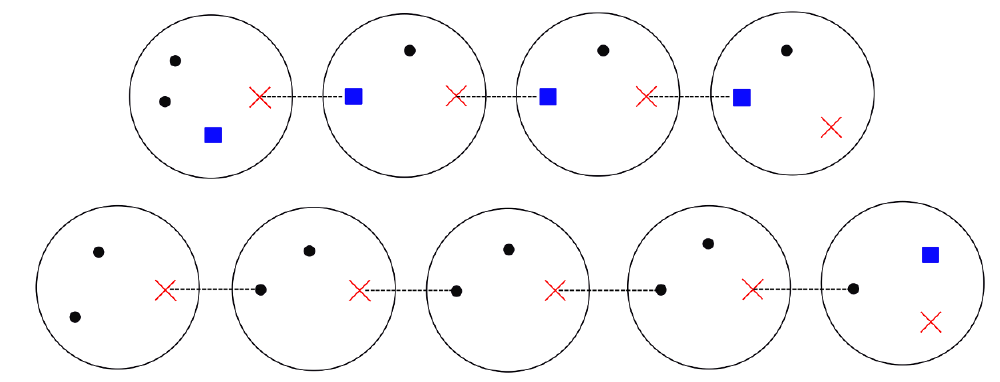
Figure 9 . The linear quiver that we will examine for k small, when g = D 5